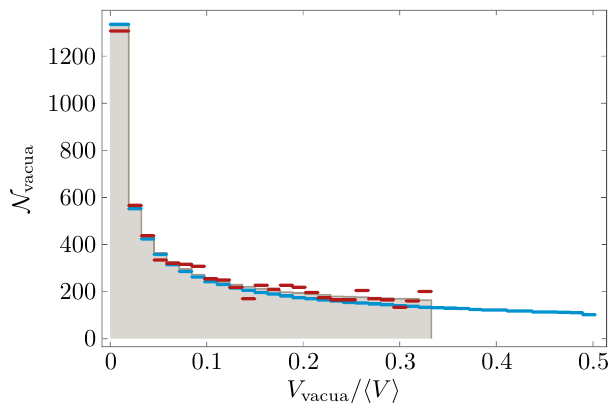
Figure 8 . Histogram showing the number of minima over the energy density, for an example with N = 5, P = 6. Shaded region: the exact distribution of all minima; red/dark: the distribution obtained via random sampling; blue/light: the distribution obtained via quadratic